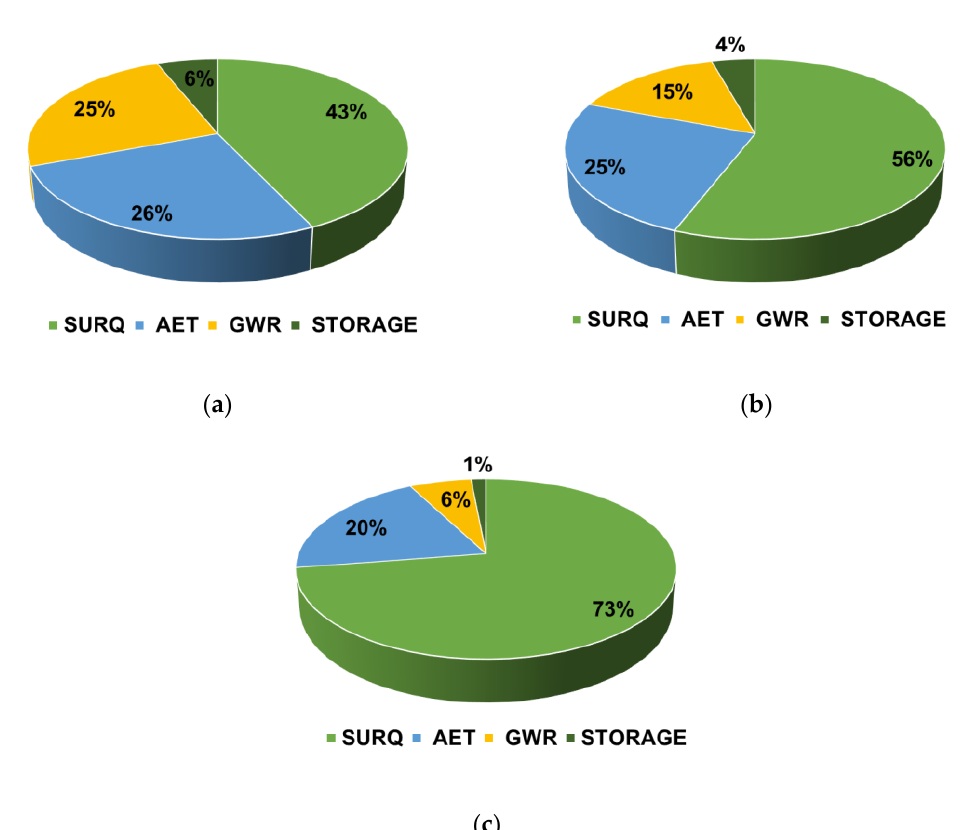
Figure 3. Distribution of water regulation ecosystem service elements in forest patches ( a ), mature oil palm ( b ), and young oil palm ( c ). Notes: SURQ: surface runoff, AET: actual evapotranspiration, GWR : groundwater recharge, STORAGE : soil water storage.